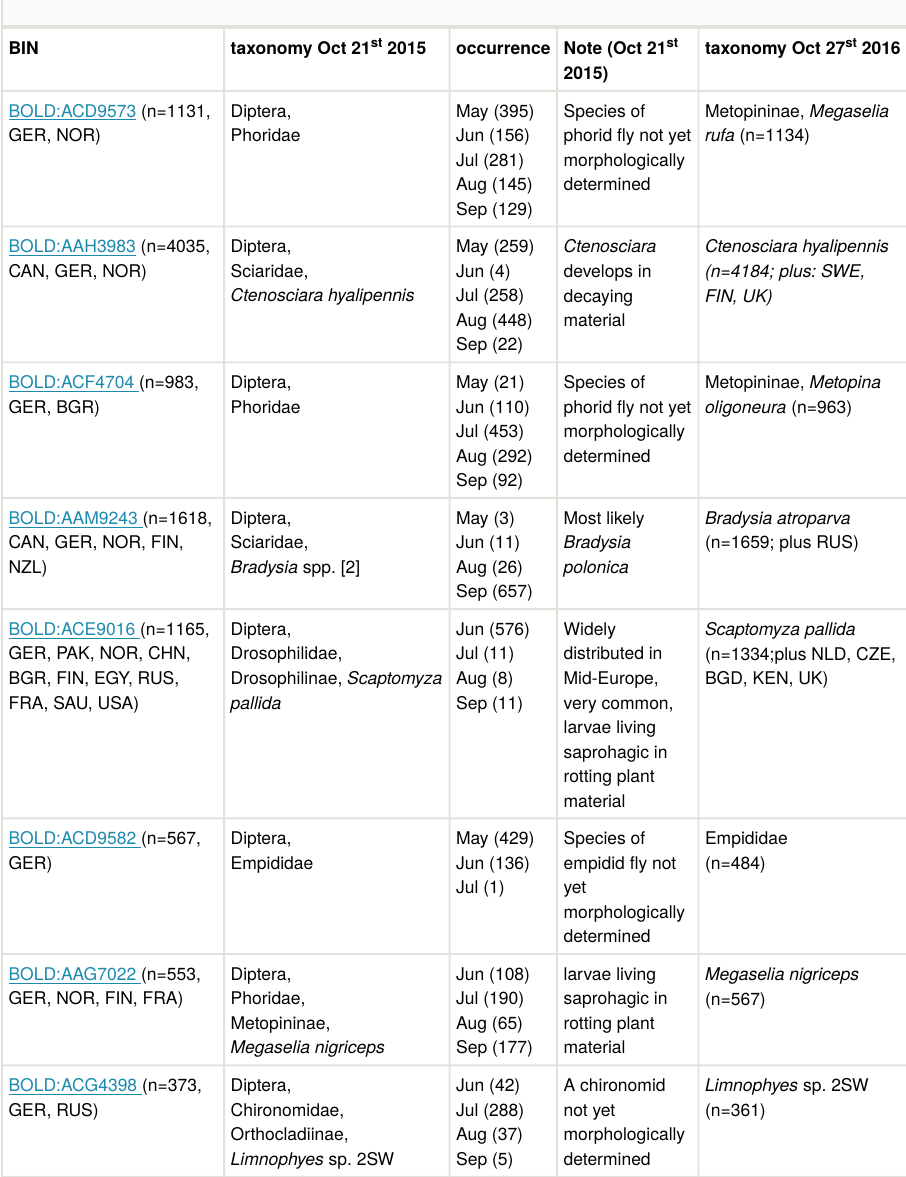
Table 1. Ten most common BINs in samples from GMTPE with BIN information from BOLD (Oct 21 2015 and Oct 27 2016): number of individuals and country of origin, taxonomy [number of species, if BIN discordant], occurrence in GMTPE samples and a general note. The hyperlink leads to the respective BIN page on BOLD with information on the geographical distribution of specimens and images of